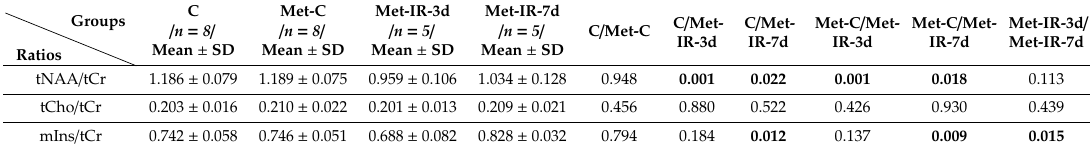
Table 1. 1 H MRS in the hippocampus of ischemized and non-ischemized animals. Relative concentrations (mean ± SD) of 1 H MRS metabolite ratios (tNAA / tCr, tCho / tNAA, mIns / tNAA) evaluated in the hippocampus for naïve control (C), Met-C, Met-IR-3d, and Met-IR-7d animal groups. Using independent-samples 2-tailed t-tests (SPSS software, version 15.0; Chicago, IL, USA), p -values were obtained expressing statistical di ff erences in metabolite ratios between groups.